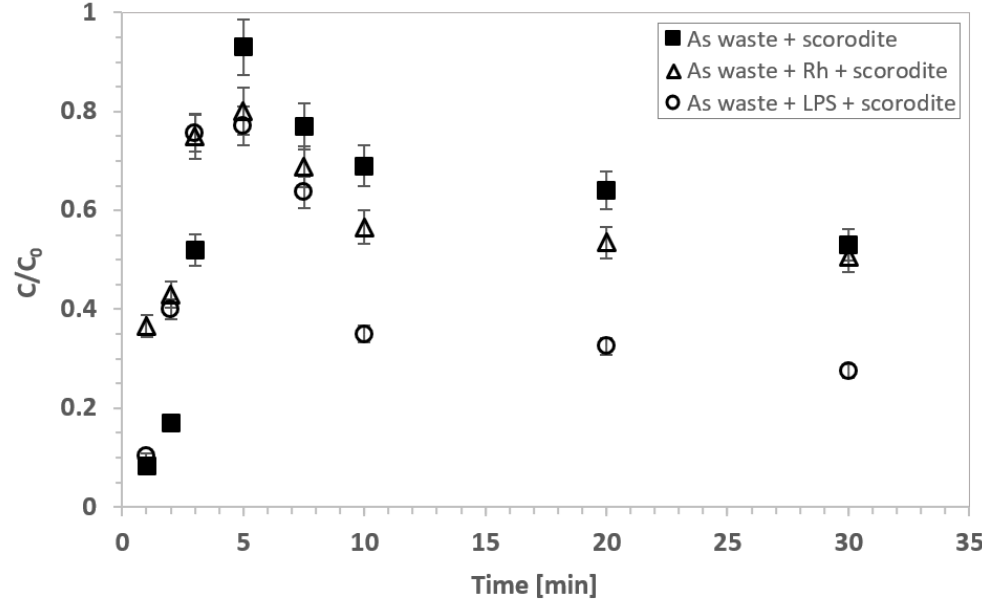
Figure 5. Adhesion of scorodite to non-modified and modified waste vs. function of time; rhamnolipids (Rh), lipopolysac- charides (LPS).